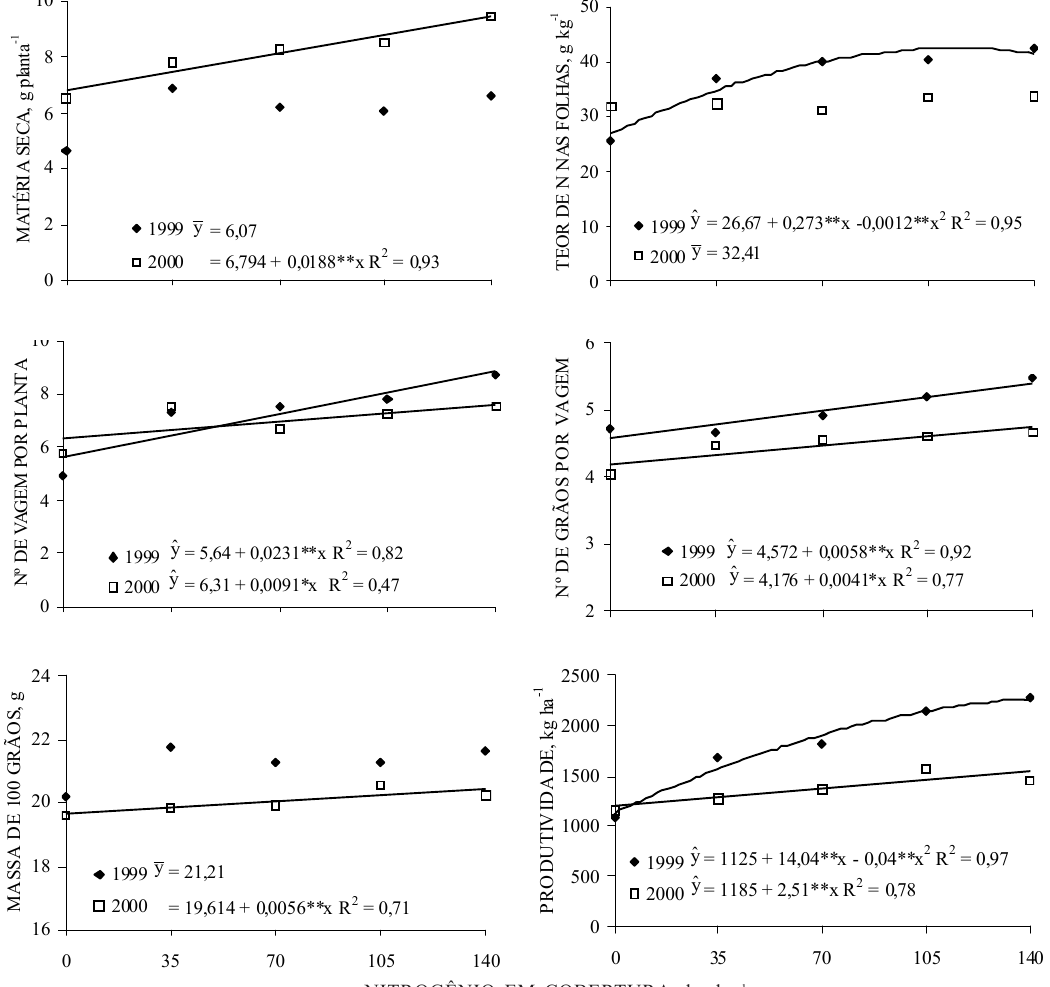
Figura 1. Matéria seca da parte aérea, teor de N nas folhas, número de vagens por planta e de grãos por vagem, massa de 100 grãos e produtividade de grãos de feijoeiro cultivar IAC Carioca no sistema plantio direto, considerando as doses de nitrogênio em cobertura (como média das épocas de aplicação). * e ** são significativos a 5 e 1 %, respectivamente, pelo teste